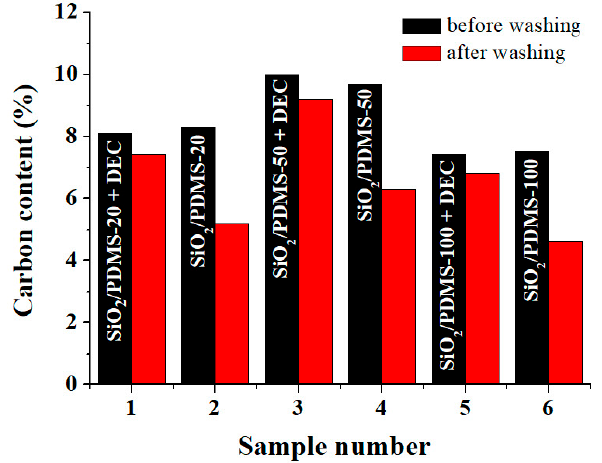
Figure 4. Histogram of carbon content for modified silicas: 1 —SiO 2 /PDMS-20 + DEC, 2 —SiO 2 /PDMS-20, 3 —SiO 2 /PDMS-50 + DEC, 4 —SiO 2 /PDMS-50, 5 —SiO 2 /PDMS-100 + DEC,